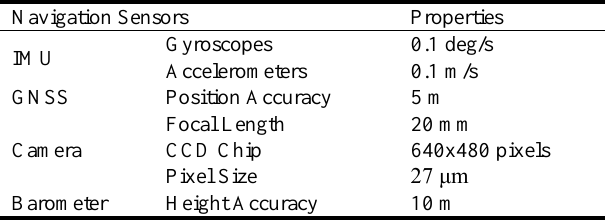
Table 1. The navigation sensor properties Navigation Sensors